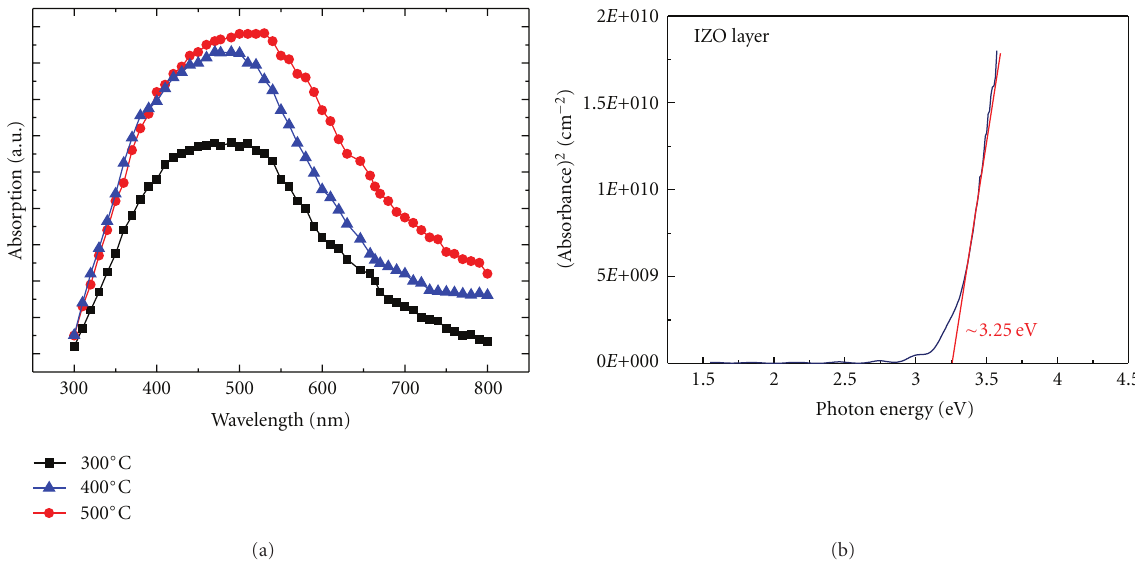
Figure 5: Absorbance spectra for (a) Cu 2 O films with thermal oxidation at various temperatures and (b) the relationship between absorption squared versus photon energy.